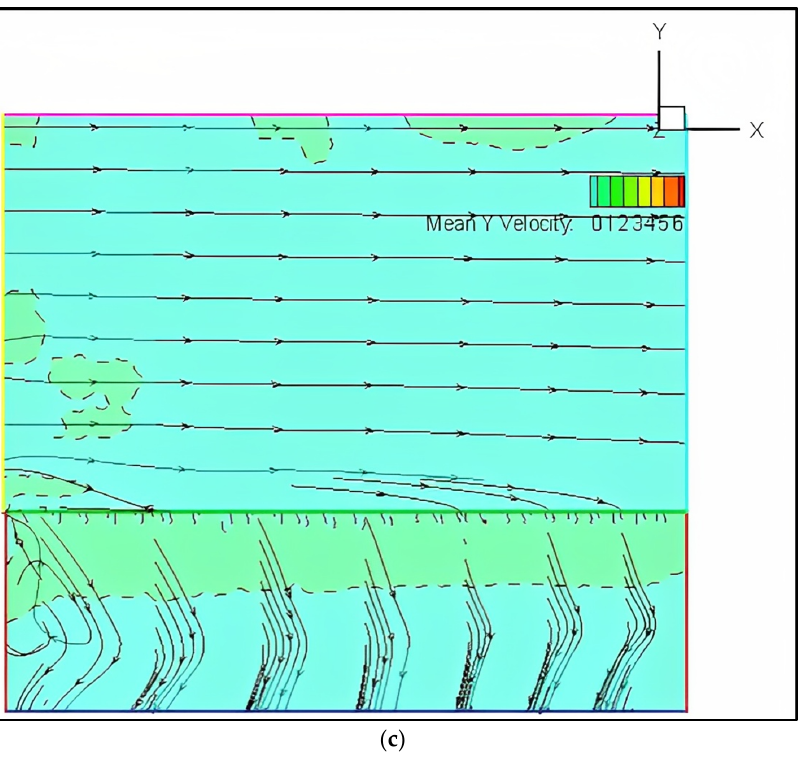
Figure 3. Comparison of CFD results and experimental data [1] for flat UTC model: ( a ) Plate surface temperature [K]); ( b ) Cavity exit air temperature [K]); ( c ) CFD Model analysis of Cavity.